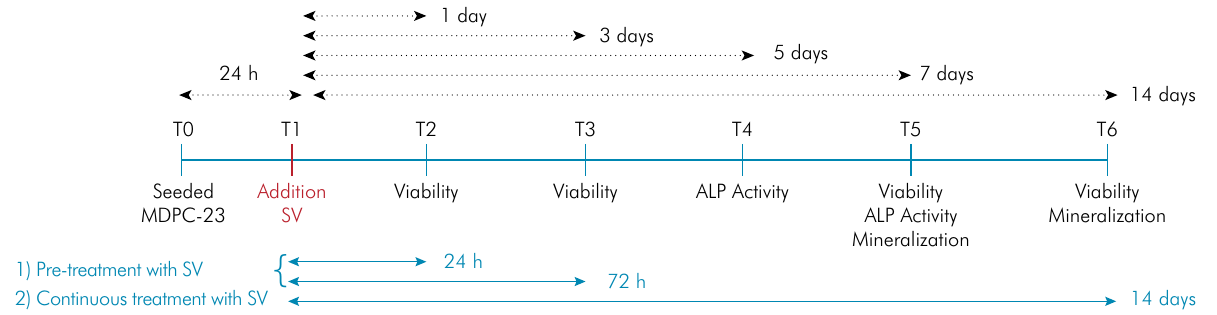
Figure 1. Experimental